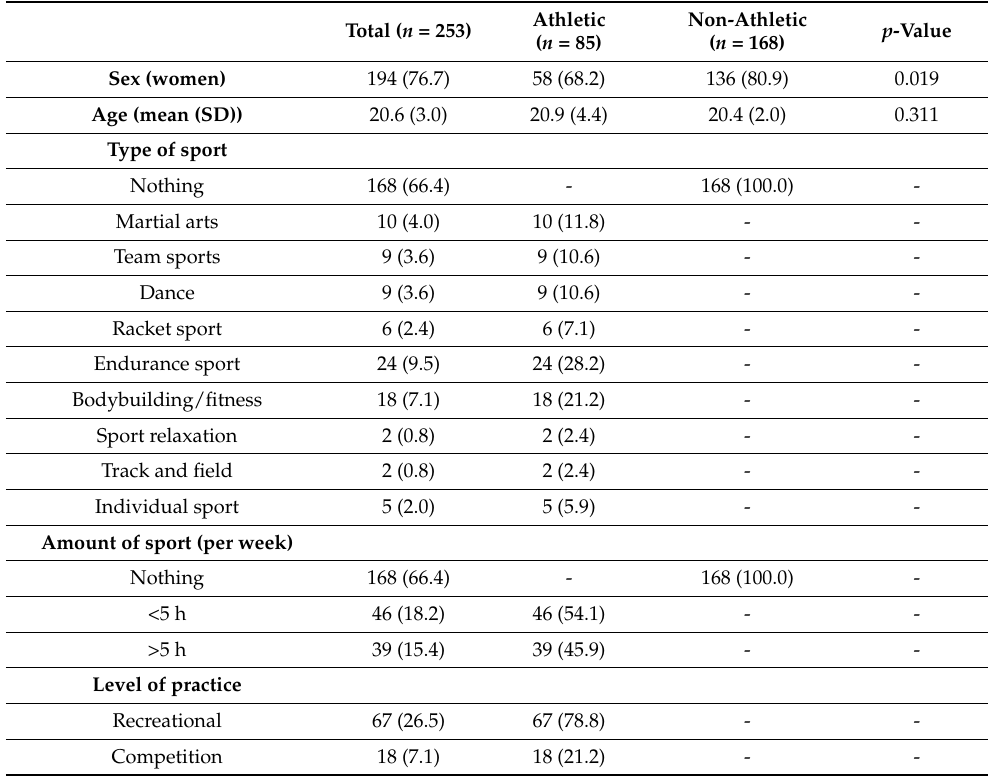
Table 1. Descriptive characteristics of student participants according to sport practice.